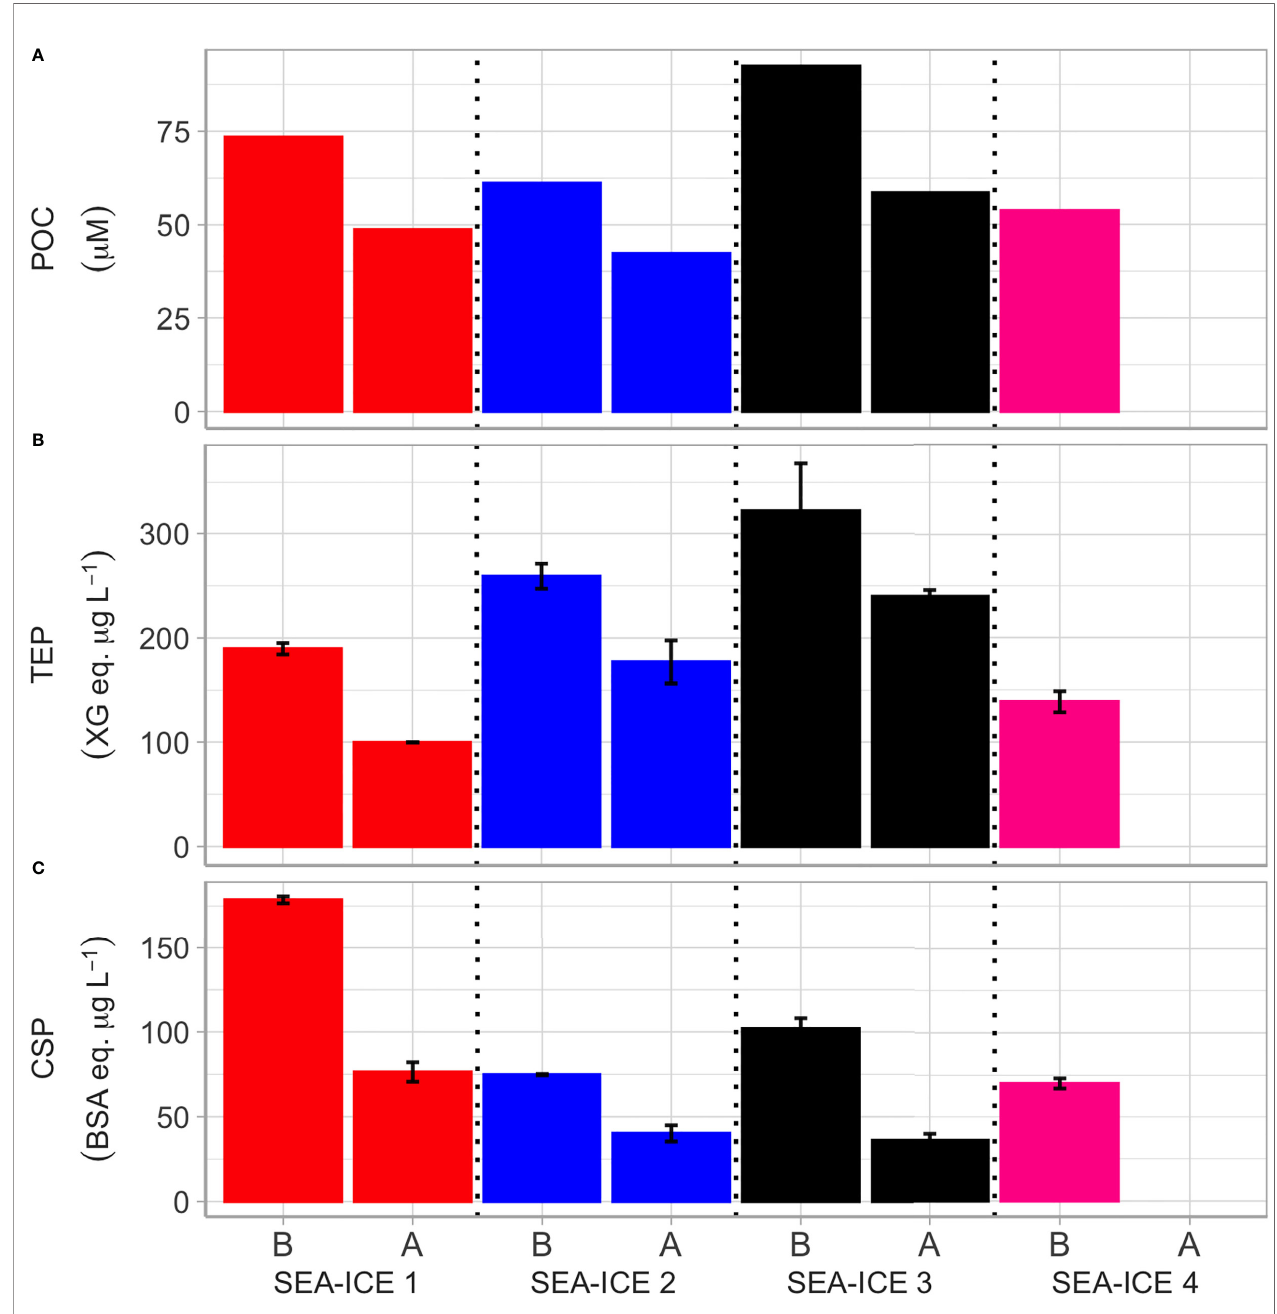
FIGURE 4 | Changes of biochemical parameters measured in the four sea ice experiments before and after the aerosol generation period. For each experiment the fi rst bar corresponds to the values estimated before ( “ B ” ) bubbling; the second bar shows the values after ( “ A ” ) bubbling. From top to bottom, the graphs show (A) POC concentrations; (B) TEP concentrations; (C) CSP